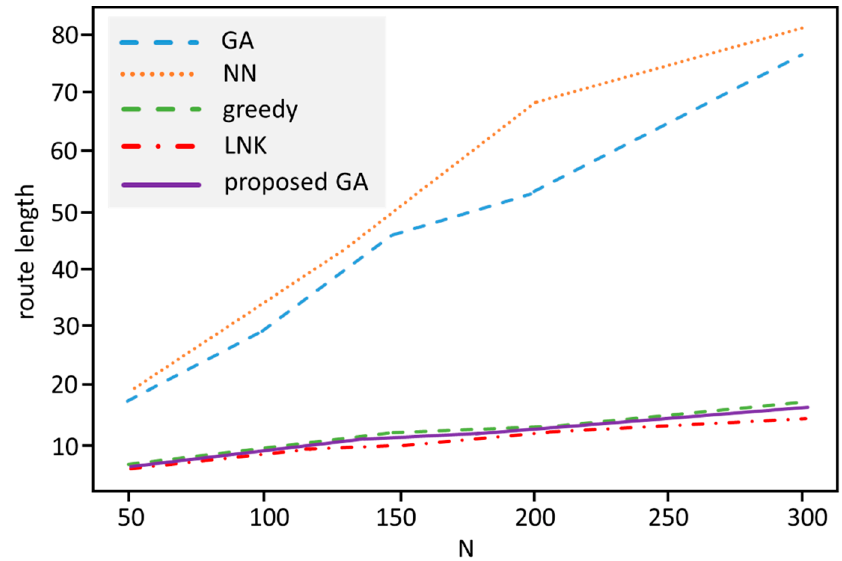
Figure 13. Route length in dependency of problem size for the TSP algorithms. Table 13. Execution time comparison of the TSP algorithms (in sec).